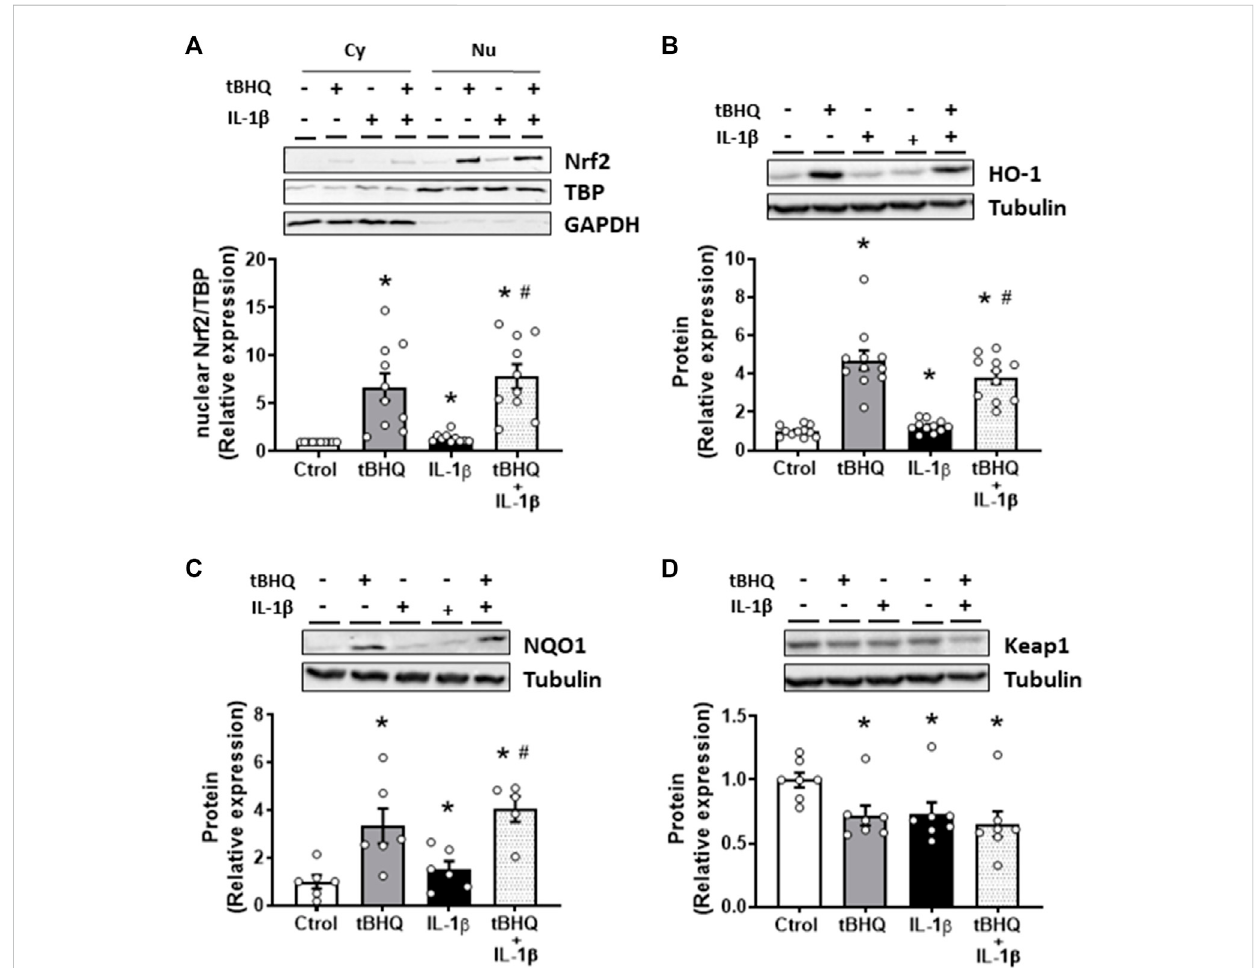
FIGURE 4 Modulation by Nrf2 activation of the IL-1 β -induced effects on the Nrf2 pathway. Effect of tert-butylhydroquinone (tBHQ, 20 μ M, 24 h), Interleukin- 1 β (IL-1 β , 10 ng/mL, 1 h) and tBHQ + IL-1 β on the nuclear Nrf2 (nuclear factor-erythroid 2-related factor 2) protein expression (A) in vascular smooth muscle cells; a representative blot of the cytosolic (Cy) and nuclear (Nu) expression is also shown; nuclear TATA-binding protein (TBP) and cytosolic GAPDH expressions are also shown to guarantee the successful cellular fractioning. Effect of tBHQ, IL-1 β and tBHQ + IL-1 β on heme oxygenase-1 [HO-1, (B) ], NAD(P)H:quinone oxidoreductase 1 [NQO1, (C) ] and Keap1 (D) protein expressions. Representative blots are shown in upper panels. * p < 0.05 vs. control; # p < 0.05 vs. IL-1 β by Student ’ s t -test ( n = 6 –